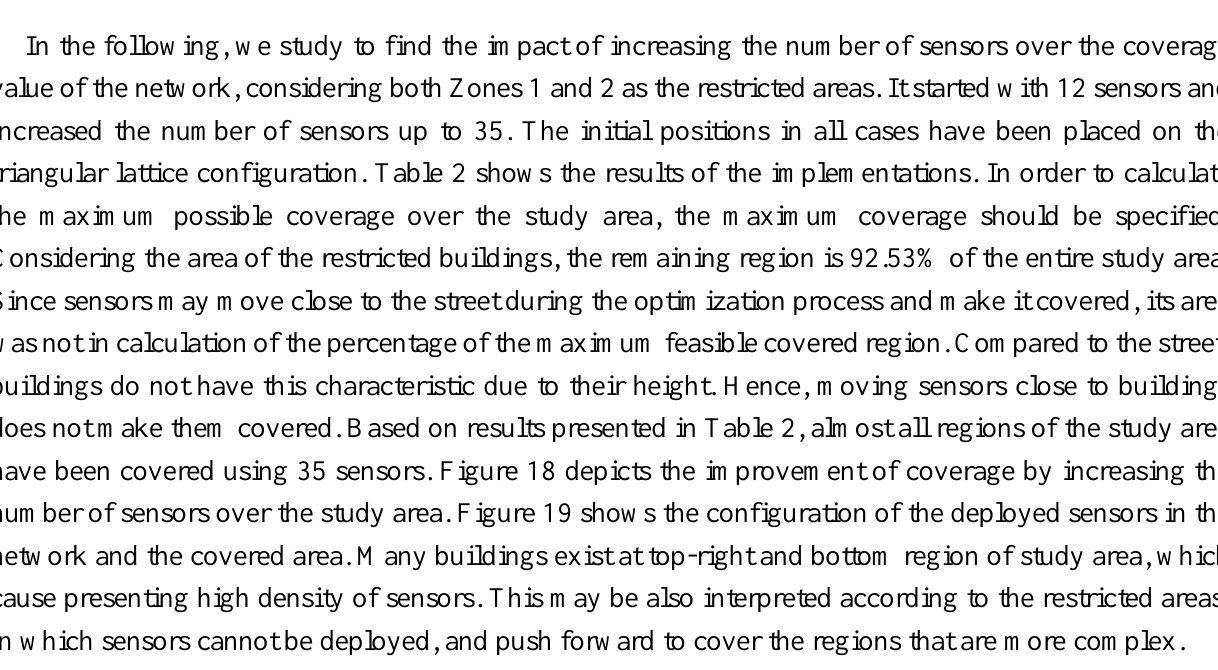
Figure 17. Coverage map of deploying 12 sensors using the context-aware method, considering the street (Zone 1), and buildings (Zone 2) as the restricted area (the red border